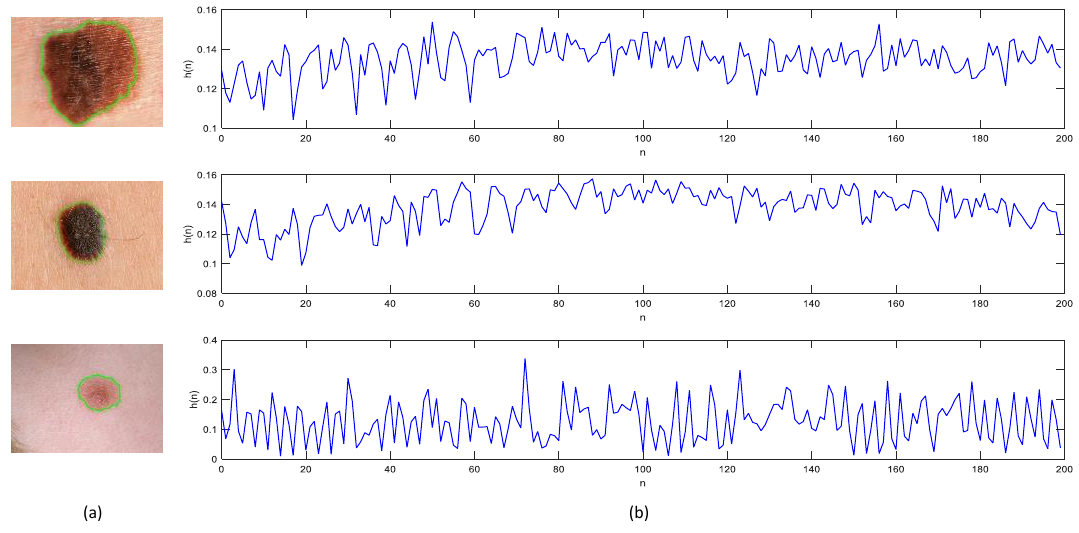
Figure 4. Sample 2D plots for the HOG based descriptor of the features extracted from three segmented skin lesion images: ( a ) original skin lesion image; ( b ) HOG-based descriptor; from top to bottom, the first two dermoscopy images contain malignant melanoma, while the last one contains benign